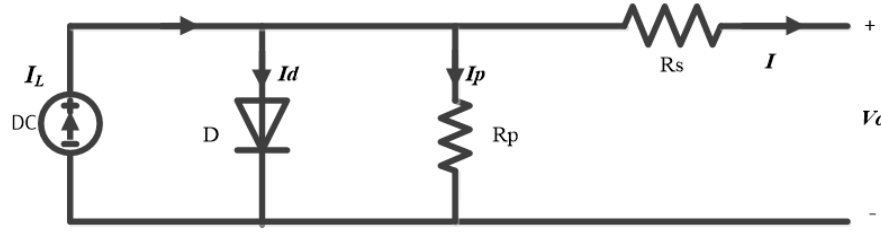
Figure 3. Equivalent circuit for solar cell.